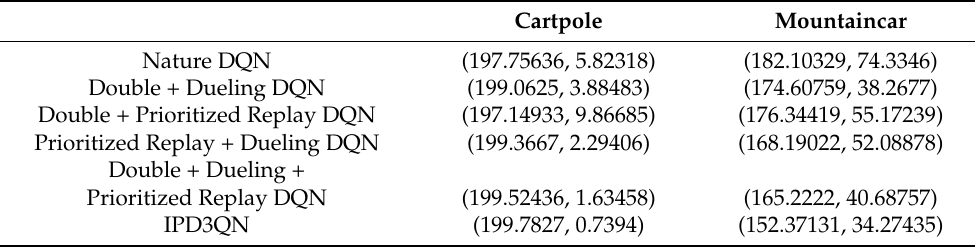
Table 5. Comparison Of Convergence Stability In Two Environments. Cartpole